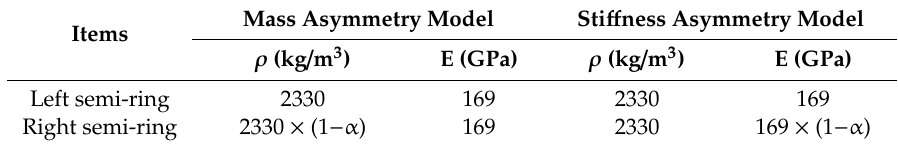
Table 2. The material parameters in mass asymmetry and Young's modulus asymmetry models.